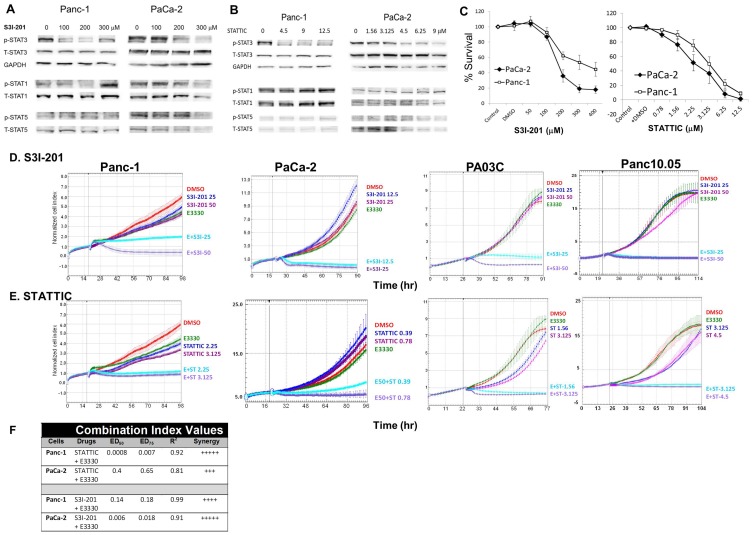
STAT3– APE1 dual targeting effectively inhibits PDAC cell proliferation.Immunoblotting of STAT proteins, p-STAT3(Y705), p-STAT1(Y701), and p-STAT5(Y694) in PDAC cells treated with S3I-201 (A) or STATTIC (B). DMSO was used as vehicle control and is included in the lane without STAT3 inhibitor. Panc-1 cells were treated with S3I-201 for 30 hr and STATTIC for 30 min. PaCa-2 cells were treated with S3I-201 and STATTIC for 24 hr. C) Dose response in PaCa-2 and Panc-1 cells following 72 hr treatment with S3I-201 or STATTIC via MTS assay. D, E) Cell proliferation after E3330 (50 µM for all lines, except 40 µM for Panc10.05) and S3I-201 or STATTIC treatment. Assays were performed in duplicate, representative experiment, from 2–4 independent experiments. F) Combination index (CI) values calculated with Calcusyn for combination of APE1 and STAT3 inhibitors at their ED50s in the MTS assay. CI values of <0.1, very strong synergy; 0.1–0.3: strong synergy; and 0.3–0.7: synergy.